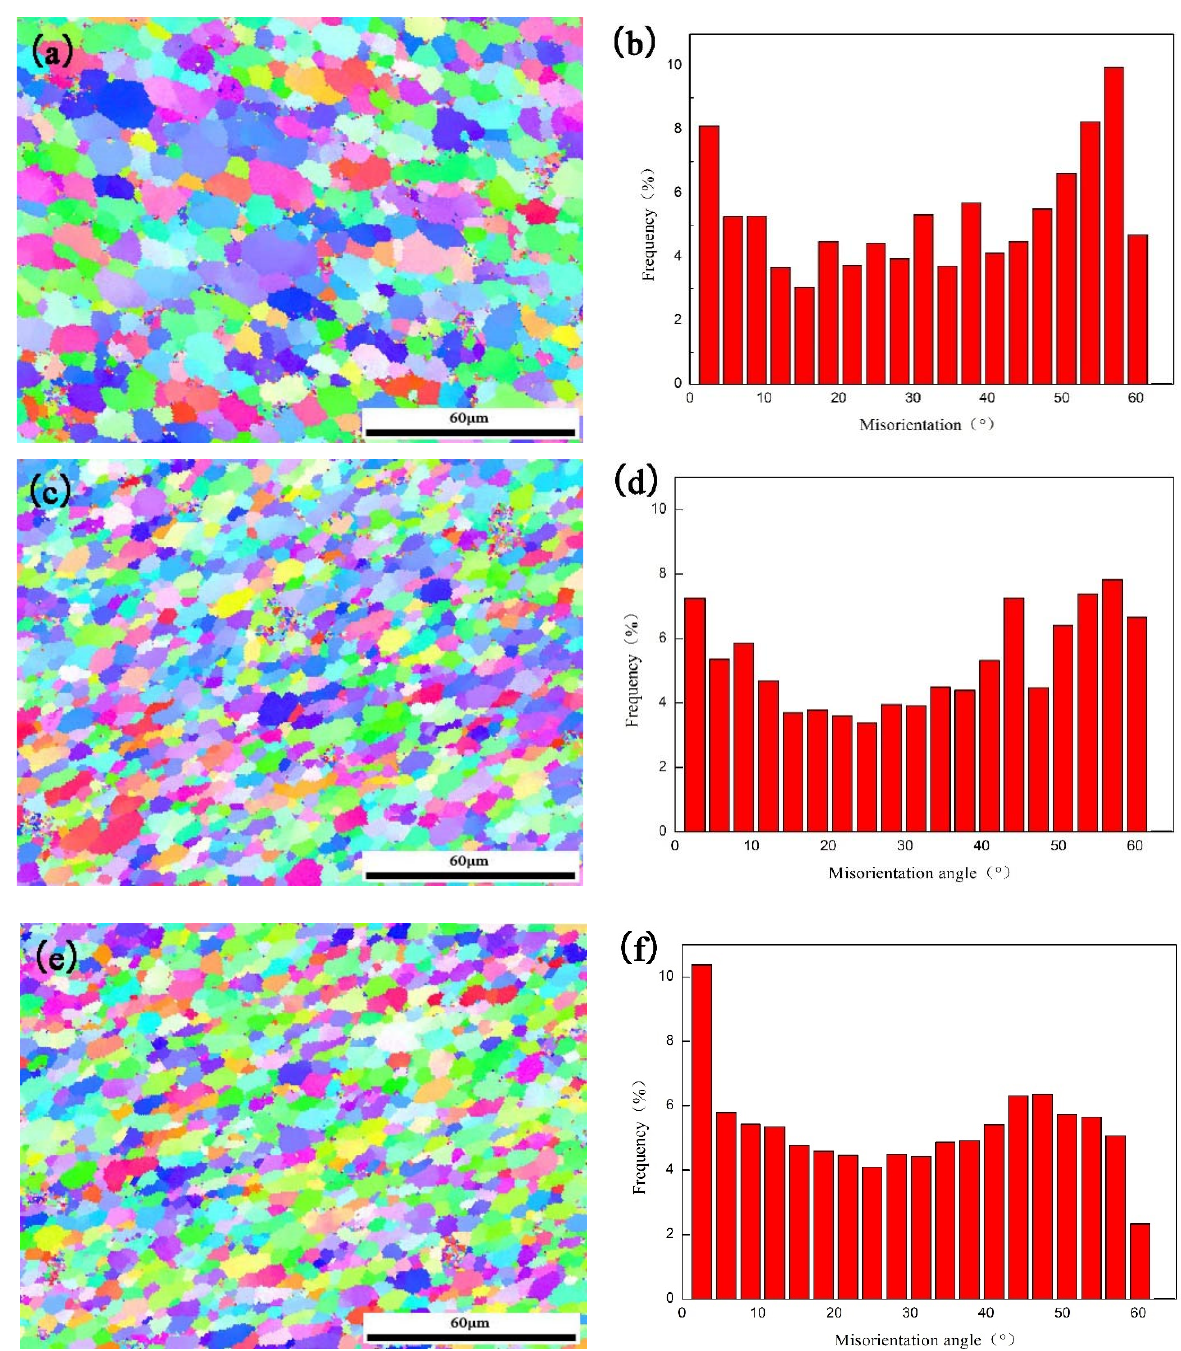
Figure 8. EBSD images and grain boundary orientation and angle distribution maps in WNZ. ( a ) tool pin A; ( c ) tool pin B; ( e ) tool pin C and corresponding grain boundary orientation angle distributions ( b , d , f ).